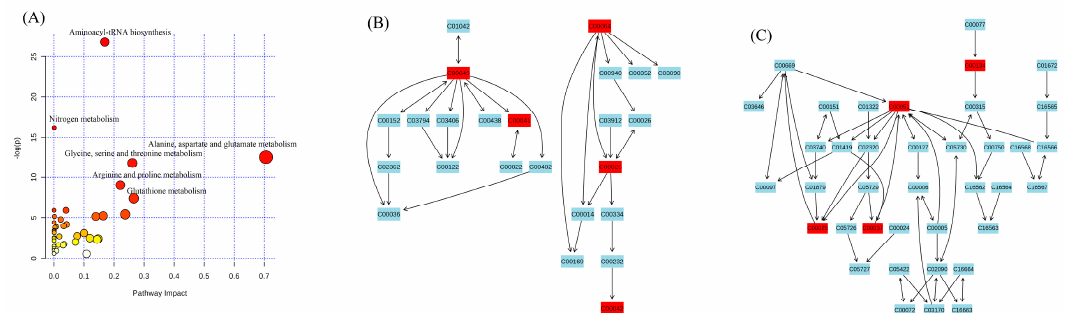
Figure 6. ( A ) In this study, metabolic analysis was used to analyze the pathway topology related to antifungal activity. The term “log p” is the conversion of the original p value calculated from enrichment analysis, and “impact” is the path impact value calculated from the path topology analysis. The bubble area is proportional to the effect of each path, and the color indicates the importance from the highest red to the lowest white. ( B ) Alanine, aspartate, glutamate metabolism; ( C ) glutathione metabolism. Supplementary Materials: The following are available online at www.mdpi.com/xxx/s1, Figure S1: title, Table